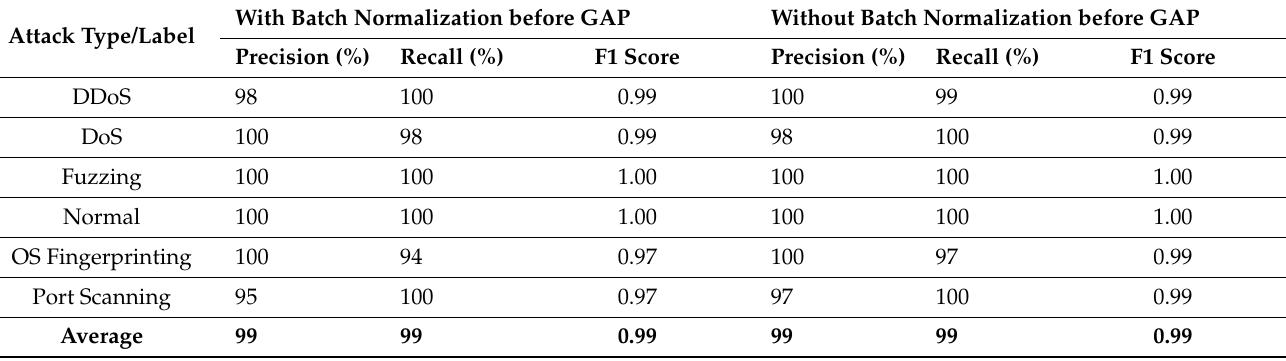
Table 4. The 5 × 5 with and without batch normalization before the global average pooling.